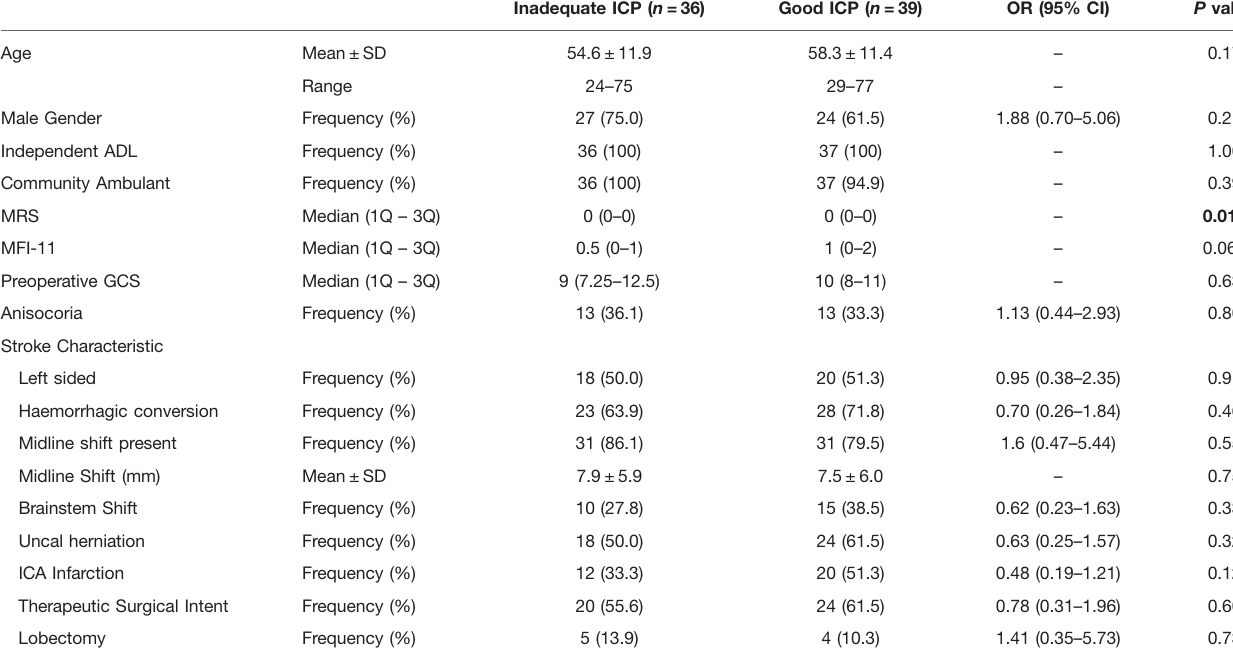
TABLE 1 | Patient characteristics amongst both groups using ICP threshold of 7